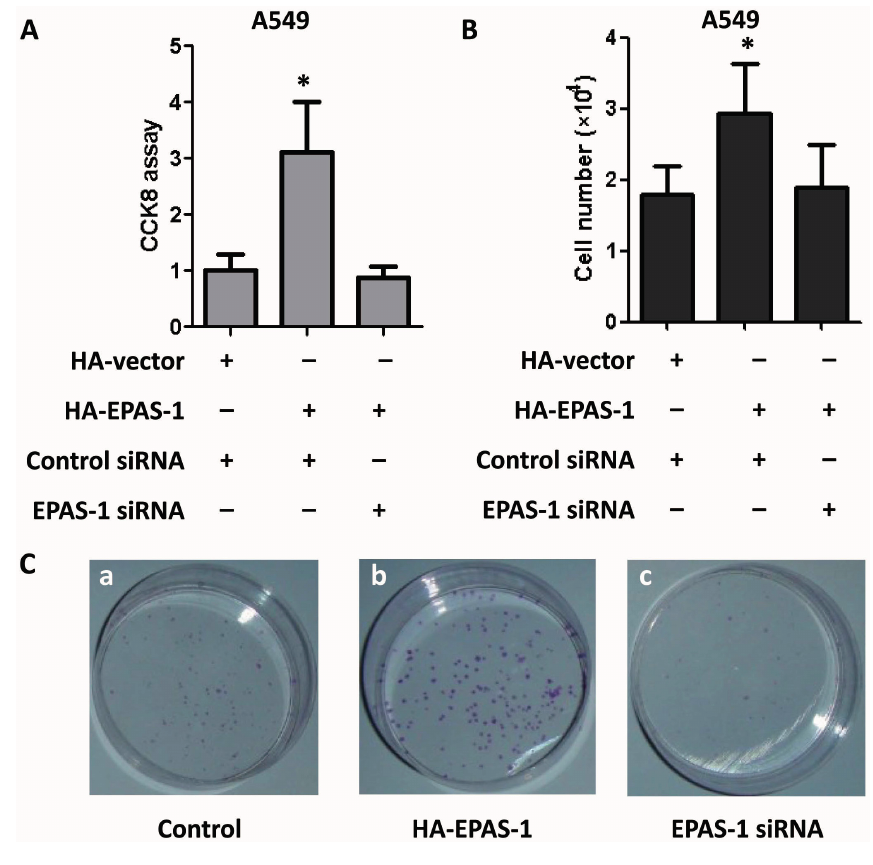
Figure 5. EPAS-1 potentiates human lung adenocarcinoma cell survival and